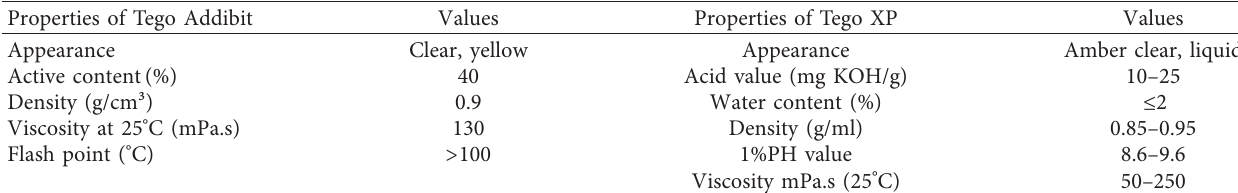
Table 3: Basic properties of silicone warm mix additives.